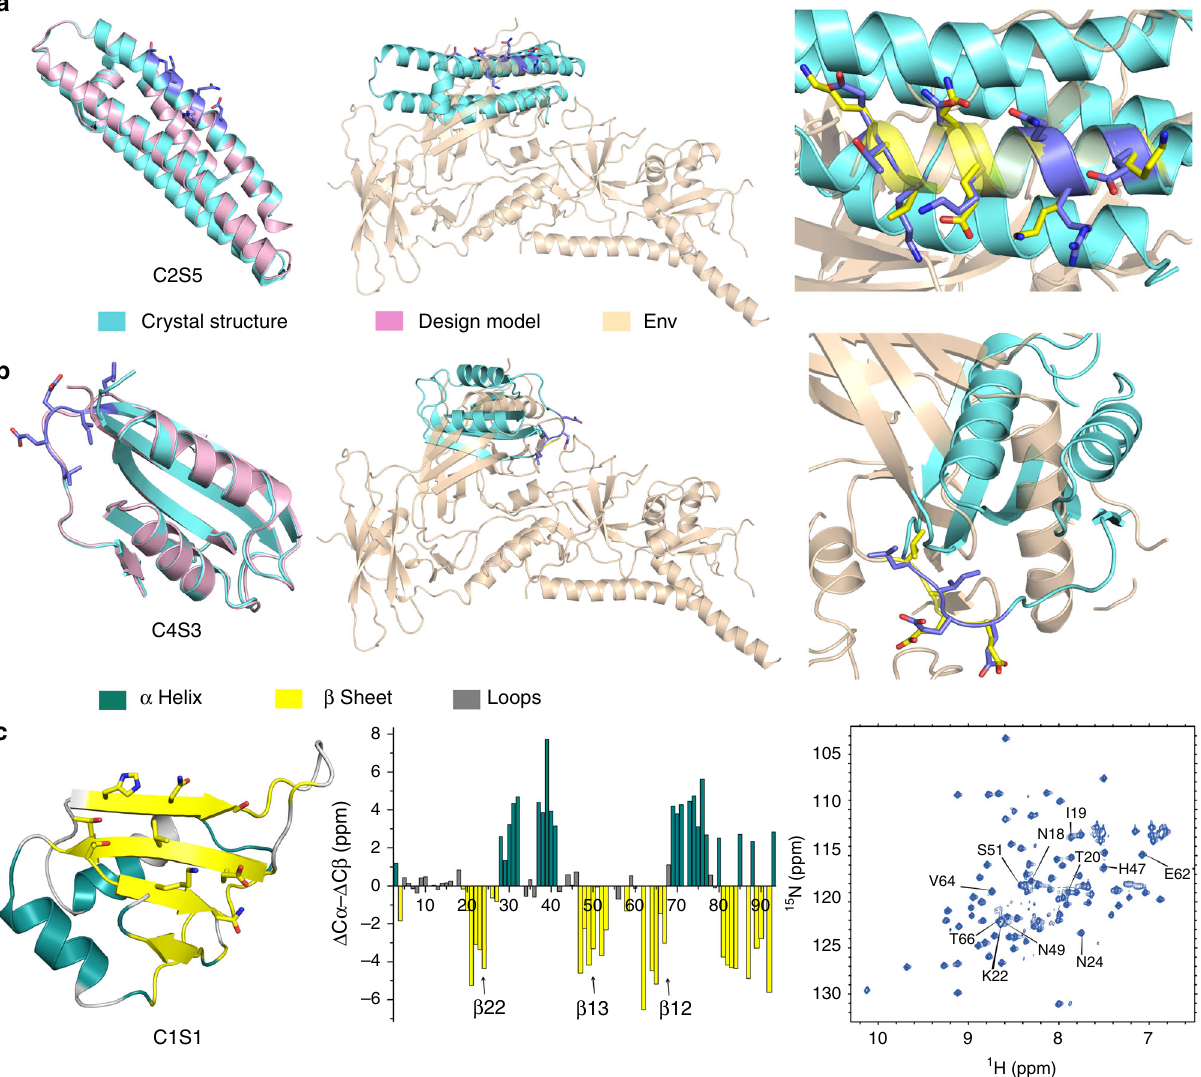
Fig. 2 Structural characterization of designed CONE immunogens. a Crystal structure of C2S5 (PDB 6CFE) aligned to the design model (left) and to the gp120 CONE 2 region (middle, PDB 5FYL, clade A sequence), with the epitope shown as sticks; (Right) Close-up view of the alignment between grafted resides in C2S5 (slate) and the gp120 (yellow) residues in their native conformations. b Crystal structure of C4S3 (PDB 6CBU) with the CONE 4 epitope shown as sticks (slate). c Secondary structure assignment based on solution NMR mapped to the C1S1 design model (left). Plot of the differences of chemical shifts Δ C α − Δ C β (middle) for each residue of C1S1 indicates which residues adopt α -helical (>1 ppm, dark cyan) or β -sheet (< − 1 ppm, yellow) structures. (Right) 1 H- 15 N HSQC spectrum with the assignments to CONE 1 residues indicated. Source data are provided as a Source Data fi le. See